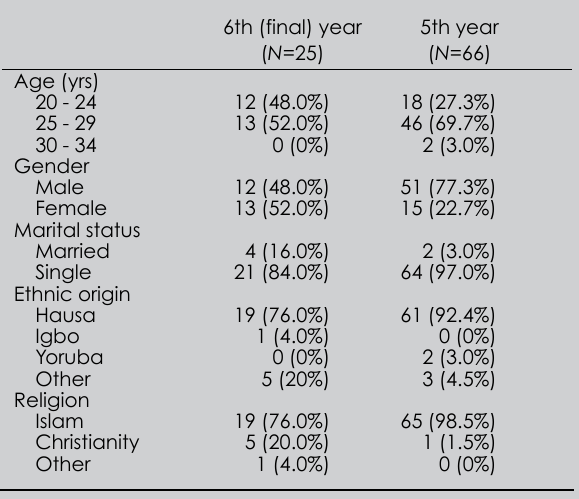
Table I. Socio-demographic characteristics of clinical medical students at Bayero University, Kano, Nigeria ( N